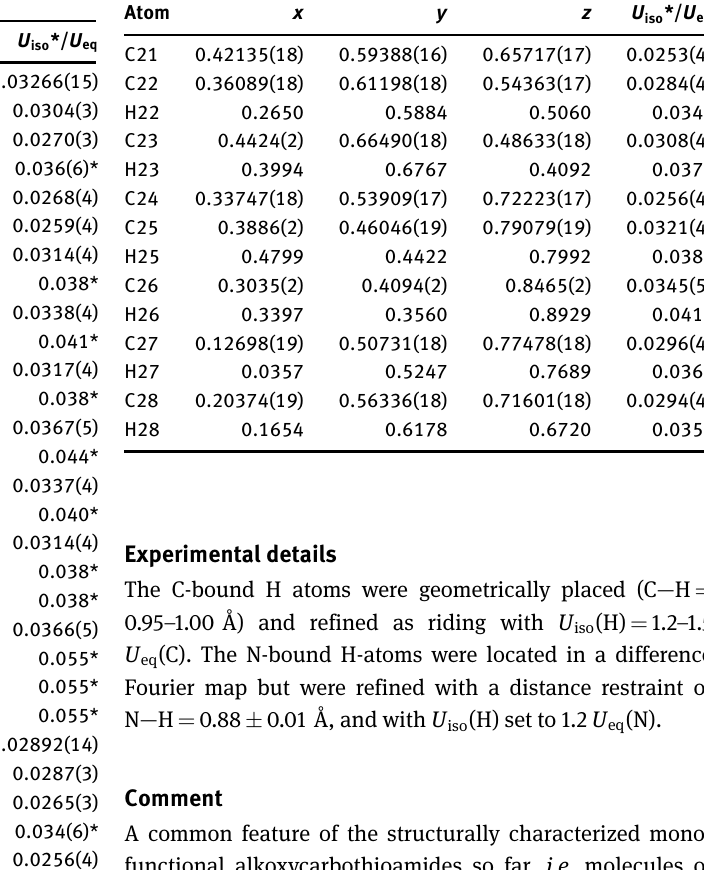
Table 2: Fractional atomic coordinates and isotropic or equivalent isotropic displacement parameters (Å 2